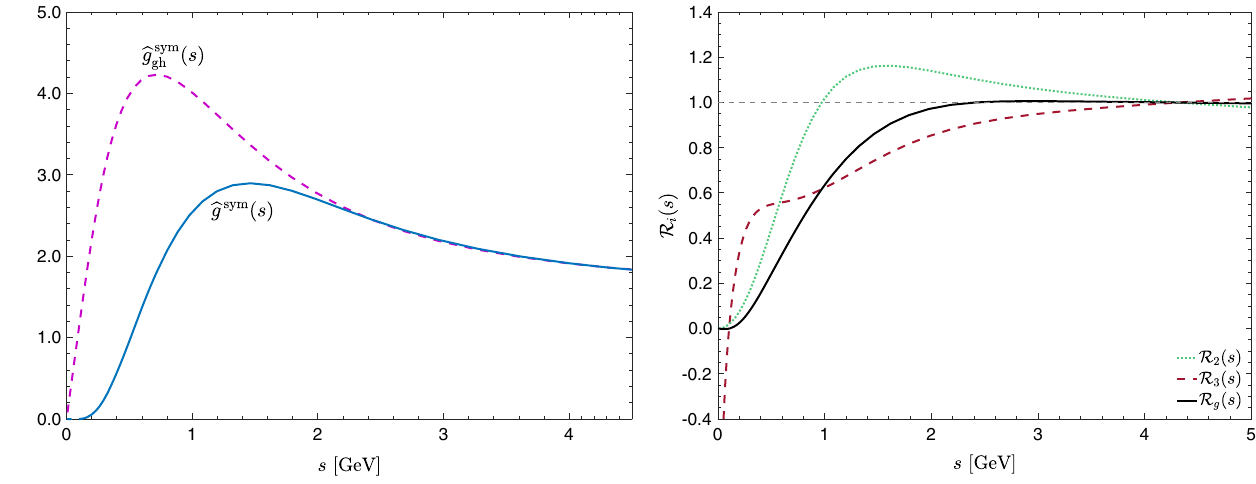
Fig. 10 Left panel: the comparison of the effective couplings, (cid:22) g sym ( s ) respectively. Right panel: the ratios R g ( s ) (black continuous), R 2 ( s ) ( s ) (magenta dashed), defined from the three- (blue solid line) and (cid:22) g sym (green dotted), and R 3 ( s ) (red dashed) introduced in the Eq. gh gluon vertex, Eq. (4.7), and from the ghost-gluon vertex, Eq. (4.9),